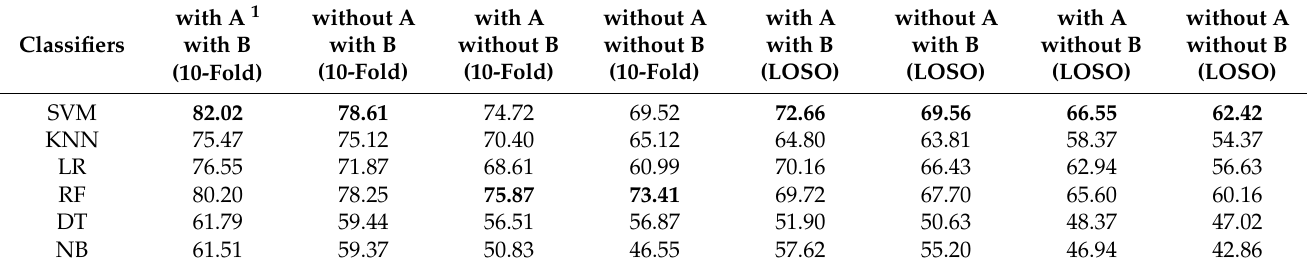
Table 6. Evaluations of the normalization method and the feature set (accuracy, in %). All best results are